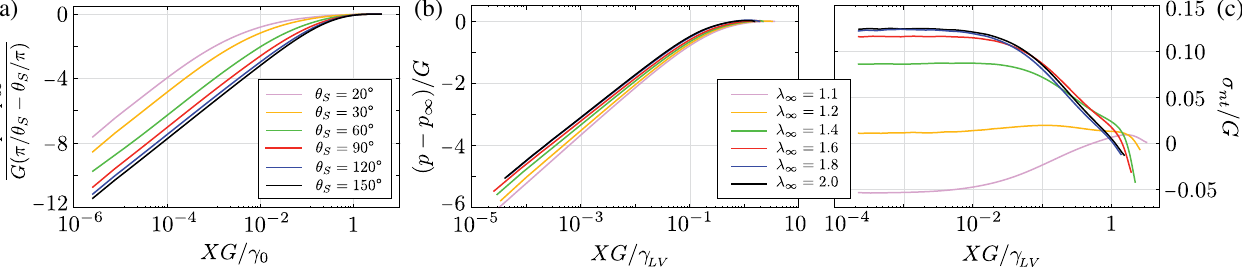
¼ 0 ) with different θ obtained by ; 1 S σ versus distance to the contact line x , ∞ . (c) Shear stress nt